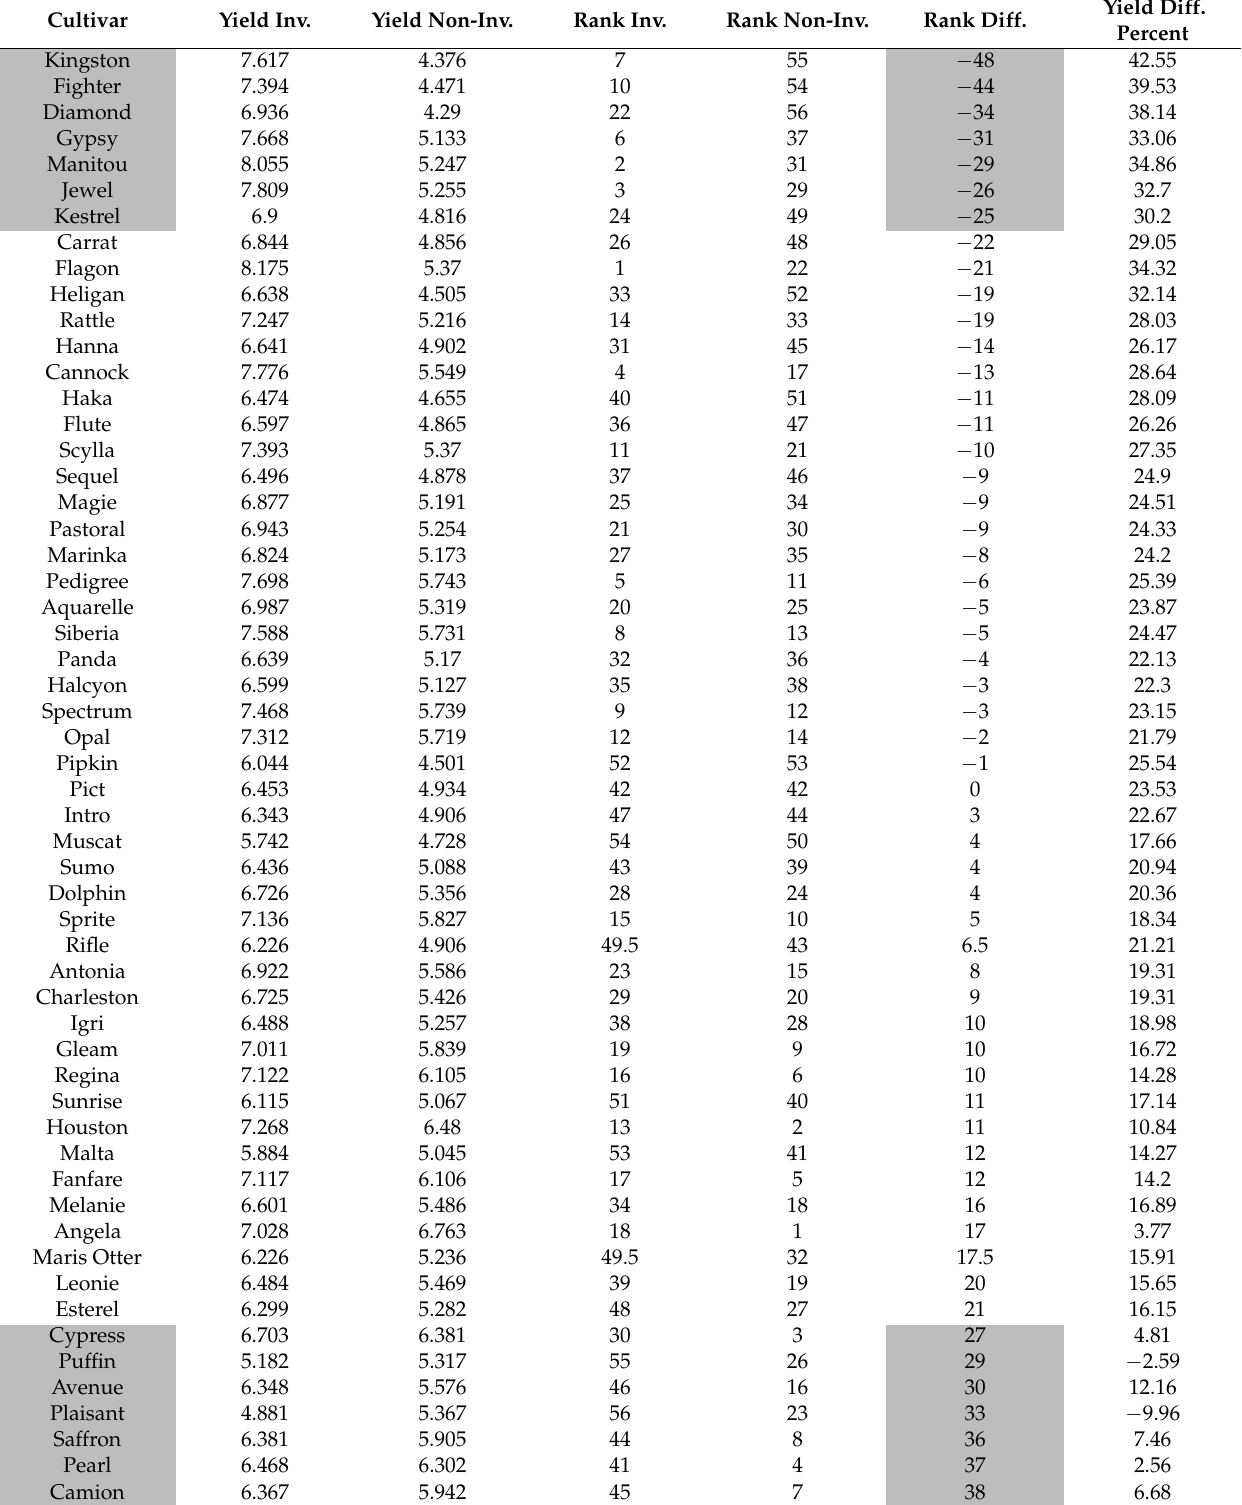
Table 8. Ranking of 56 winter barley cultivars grown in the 2008 trial by the difference between their inversion and non-inversion yield